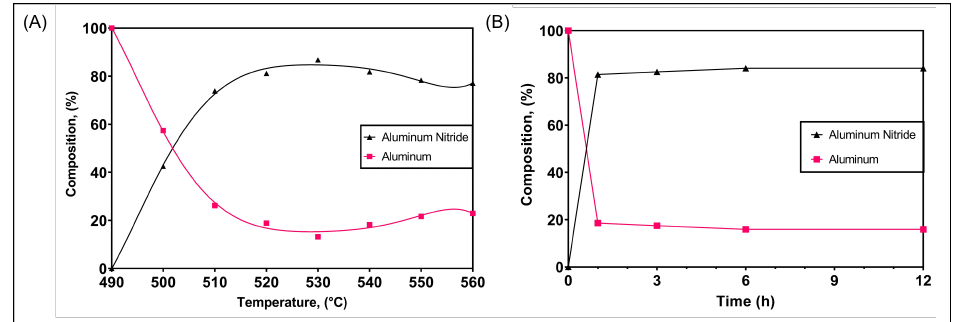
Figure 9. Proportions of AlN formed with temperature and time: ( A ) quantitative phase analysis results of the proportions of Al and AlN after nitriding for 6 h at various temperatures and ( B ) quan- titative phase analysis of the proportions of Al and AlN after nitriding at 530 °C for 1, 3, 6 and 12